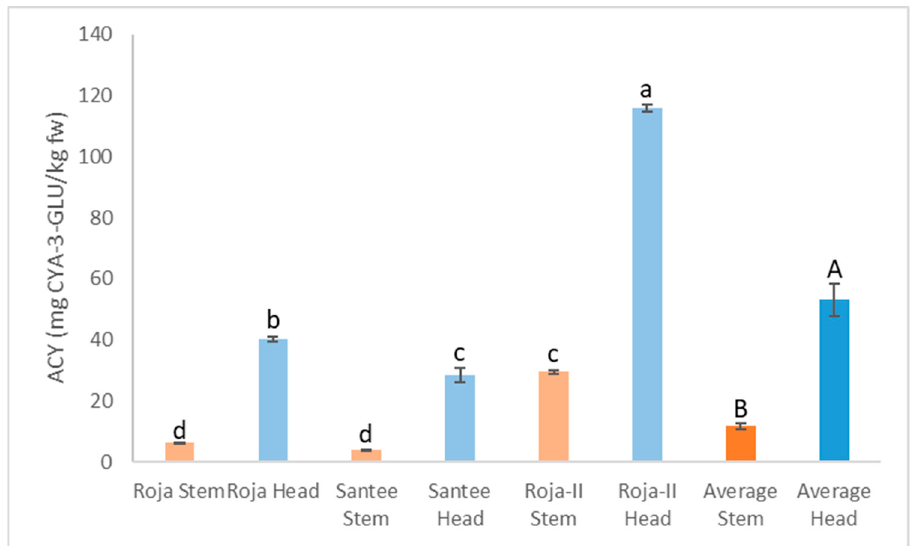
Figure 2. Average values of Total Phenol Content (TPH) with standard deviation of different culti- vars and type of tissues of Broccoli: Roja, Santee and Roja-II harvest divided into head and stem, and their average. Values with the same lowercase letter were not significantly different (Test SNK p ≤ 0.05, n = 3). Lowercase letters refer to Roja, Santee and Roja II harvest divided into head and stem. Values with the same uppercase letter were not significantly different (Test SNK p ≤ 0.05, n = 9). Uppercase letters refer to head and stem average values.